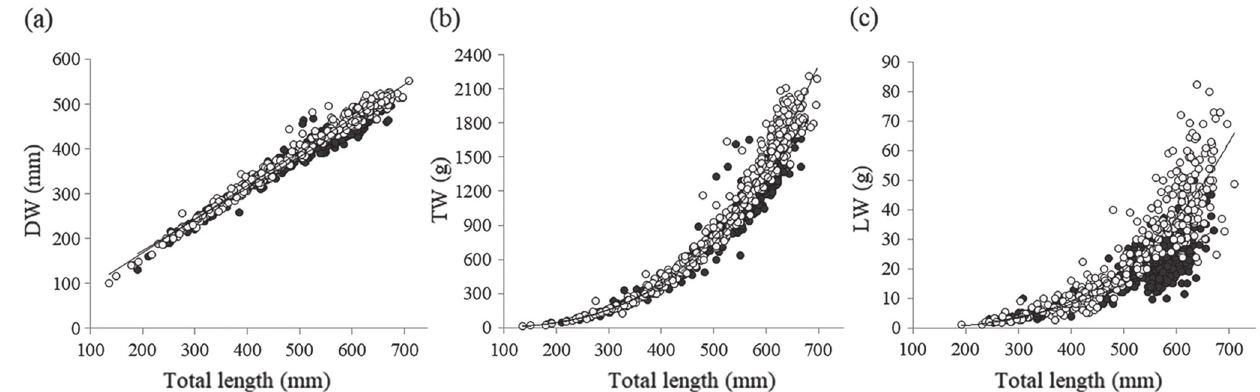
Fig. 3 . Relationship between total length and a. disc width (DW); b. total weight (TW) and c. liver weight (LW) of males (dark dots) and females (light dots) Atlantoraja cyclophora . The curves were fitted by: a. males DW = 33.51 + 0.71TL(r=0.96, n=438), females DW = 18.70 + 0.71TL (r=0.98, n=435); b. males TW = (5 x 10 -6 )TL 3.031 (r=0.98, n=446), females TW = (2 x 10 -6 )TL 3.162 (r=0.98, n=435); c. males LW = (5 x 10 -7 )TL 2.759 (r=0.83, n=365); females LW =(9 x 10 -9 ) TL 3.459 (r=0.90, n=360).